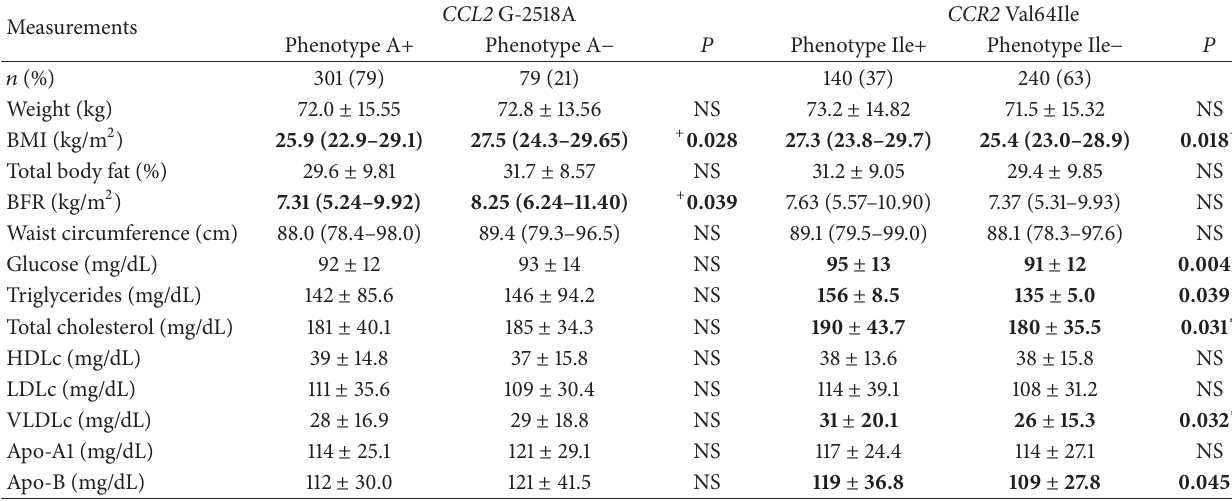
Table 4: Comparisons of body fat measurements and lipid profile between CCL2 G-2518A and CCR2 Val64Ile phenotype carriers.